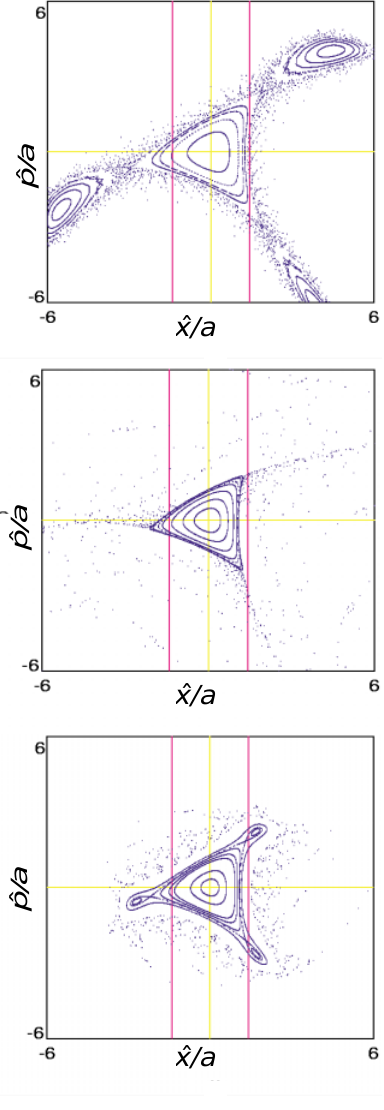
FIG. 11. (Color) (Top) Pure sextupole with v 0 (cid:1) 0.34 3 2 p FIG. 12. (Color (Top) Pure sextupole with v 0 (cid:1) 0.32 3 2 p and a ˆ K 0 2 (cid:1) 0.14 . (Center) Exact sextupole 1 space charge with and a ˆ K 0 2 (cid:1) 0.3 . (Center) Exact sextupole 1 space charge with (cid:1) 0.3 , and ˆ j (cid:1) 0.05 . (Bottom) Exact (cid:1) 0.14 , and ˆ j (cid:1) 0.05 . (Bottom) Exact v 0 (cid:1) 0.32 3 2 p , a ˆ K 0 v 0 (cid:1) 0.34 3 2 p , a ˆ K 0 2 2 sextupole 1 space charge where the space charge force F (cid:2) x (cid:3) sextupole 1 space charge where the space charge force F (cid:2) x is replaced with a polynomial approximation of degree 5. The phase plots are in the coordinates ˆ x , ˆ p normalized to the core radius a . The dynamic aperture is comparable to the normalized core radius ˆ x dyn (cid:4) ˆ a (cid:4) 1.4 a . To compare these values with a p n (cid:1) v (cid:1) 4.34 3 2 p , and for a (cid:1) 25 mm we have ˆ K 2 (cid:1) ˆ K 0 2 (cid:1)